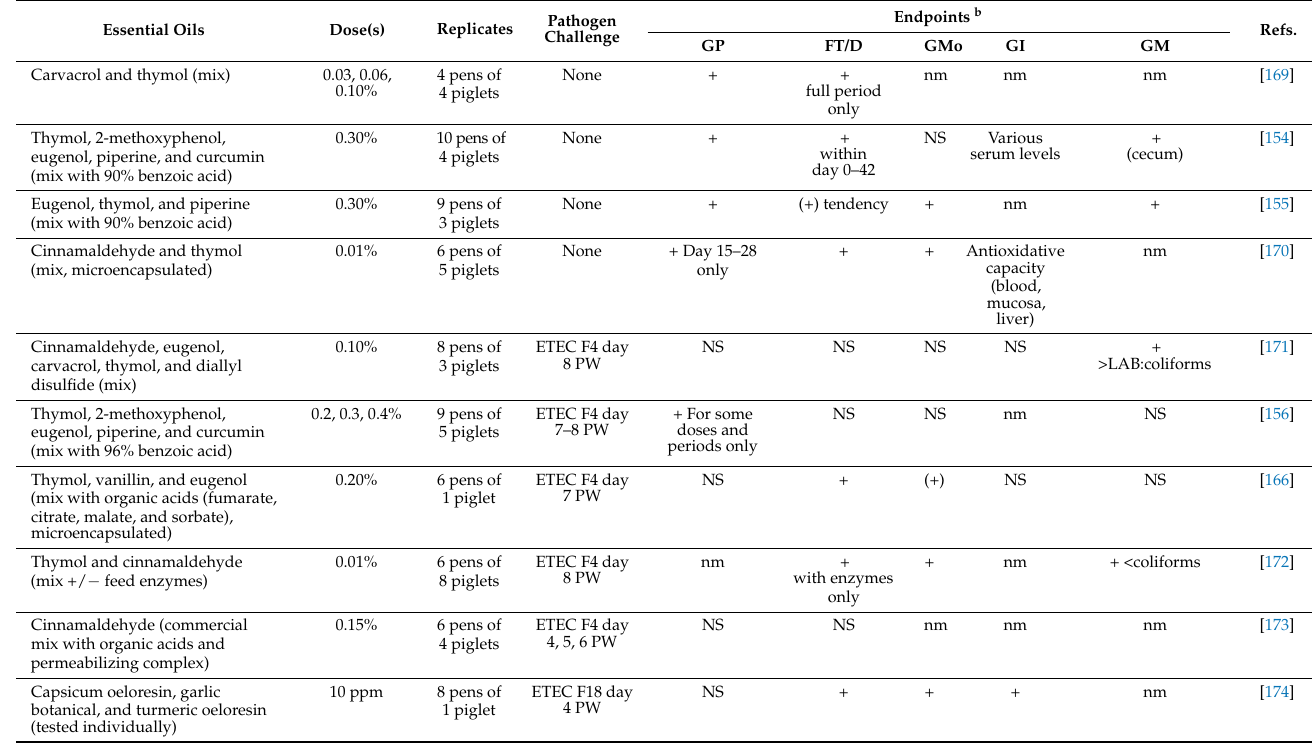
Table 5. Effects a of essential oils on various parameters in